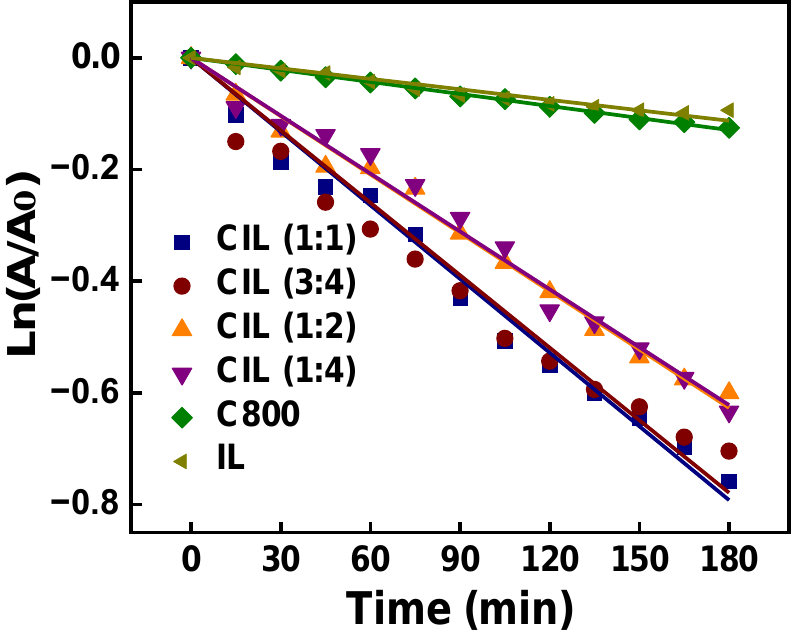
Figure 10. Pseudo-first-order kinetics of photocatalytic activity of the synthesized materials. Table 3. Pseudo-first-order rate constants for the photodegradation of MB.